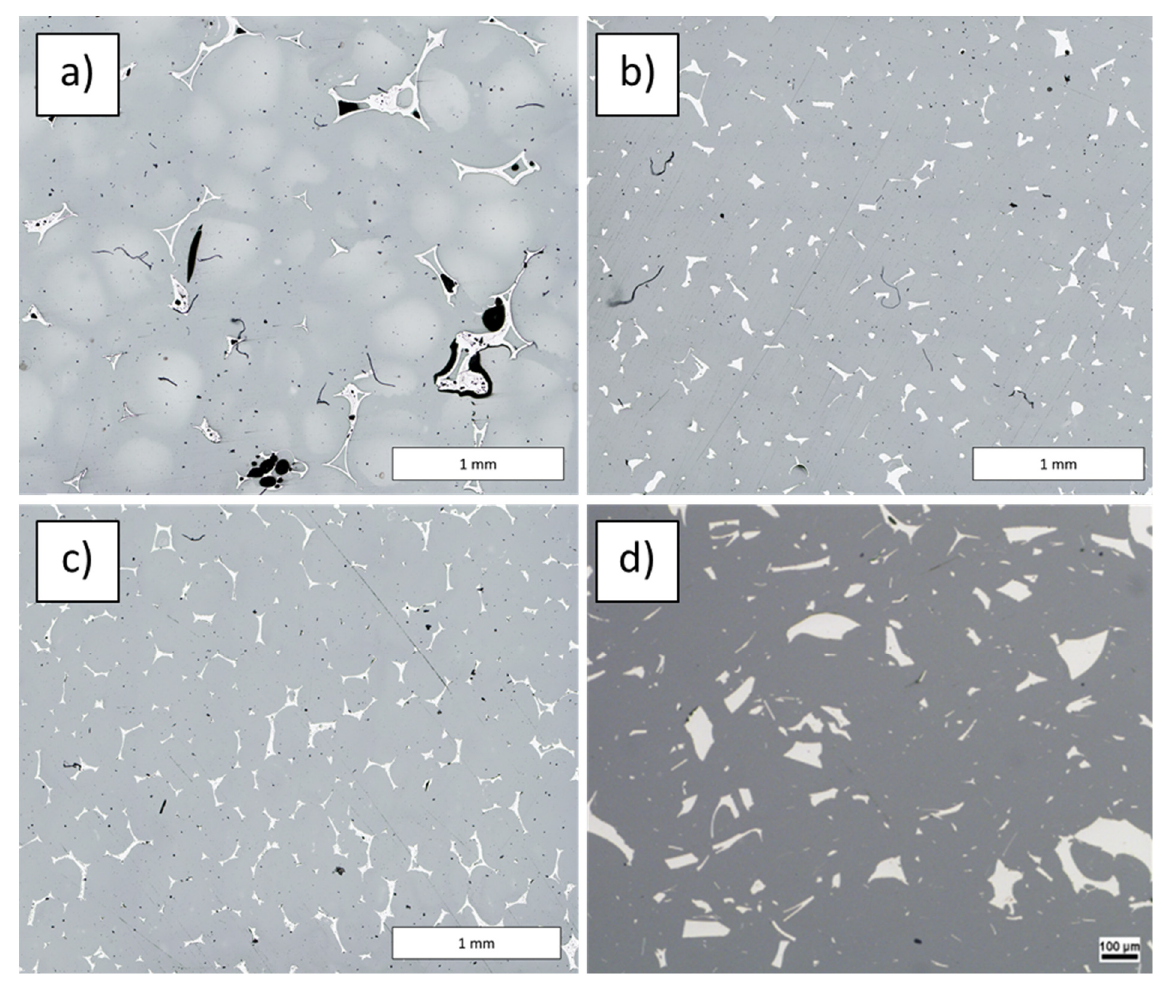
Figure 4. Microstructure of examined C of —epoxy composites with different foam porosity: ( a ) C of 20 ppi, ( b ) C of 40 ppi and ( c ) C of 60 ppi, ( d ) CF with closed pores.